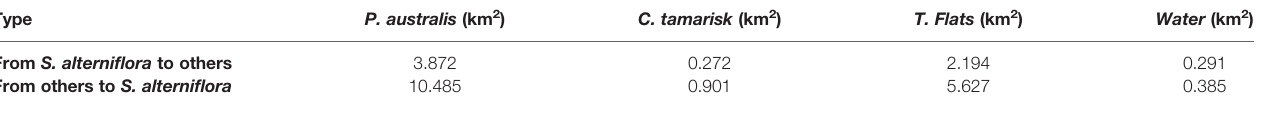
TABLE 4 | The land use type transfer matrix from 2018 to